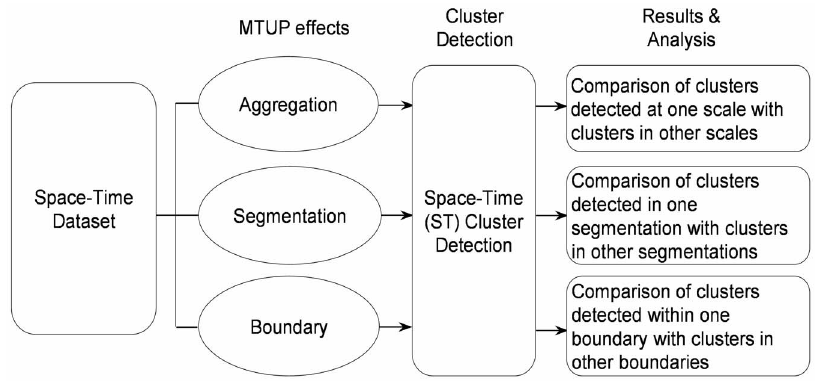
Figure 3. Our experimental approach to examining the MTUP effects on space-time cluster detection.